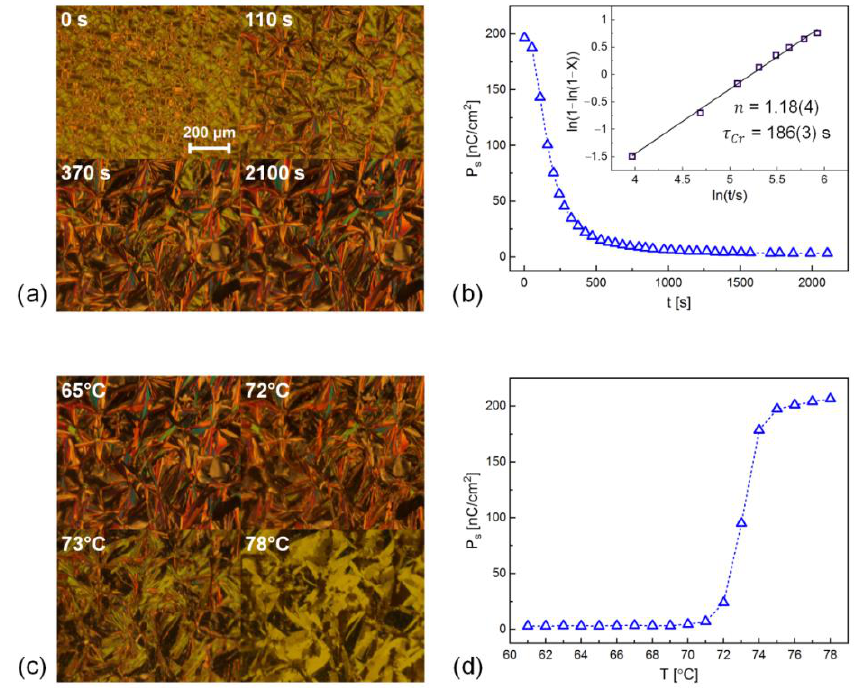
Figure 9. Textures ( a , c ) and spontaneous polarization ( b , d ) of 4HH registered during cold crystal- lization in 60 °C vs. time ( a , b ) and on subsequent heating to 78 °C ( c , d ). The dashed lines are a tion in 60 ◦ C vs. time ( a , b ) and on subsequent heating to 78 ◦ C ( c , d ). The dashed lines are a guide to guide to eye. Inset in ( b ) is the Avrami plot of crystallization degree 𝑋(𝑡) calculated according to eye. Inset in ( b ) is the Avrami plot of crystallization degree X ( t ) calculated according to Equation (4) Equation (4) with a linear fit and obtained 𝑛 and 𝜏 𝐶𝑟 values. with a linear fit and obtained n and τ Cr